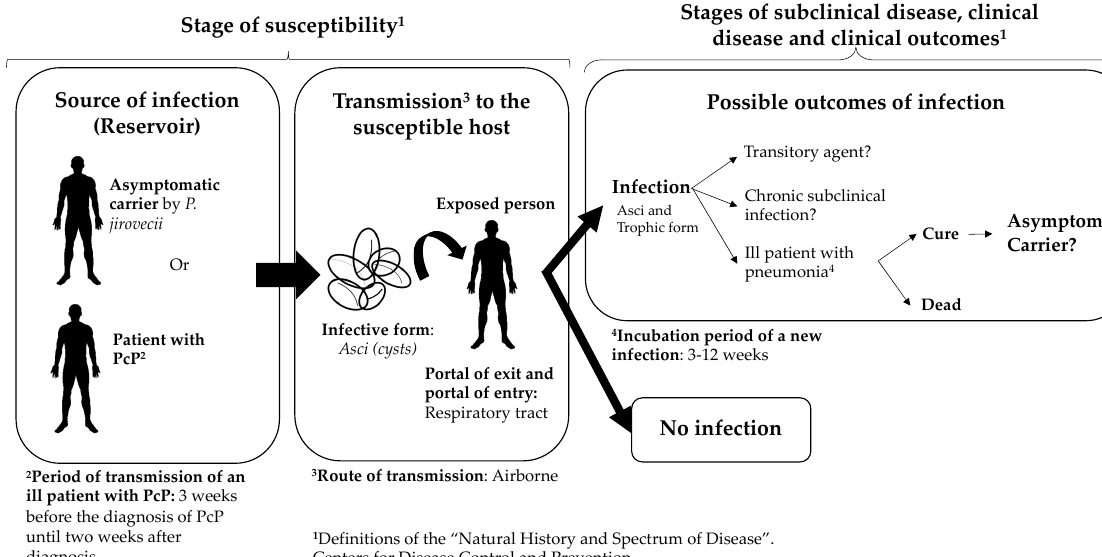
Figure 2. Hypothetical representation of the natural history of Pneumocystis jirovecii . Some of the references that support the definitions used in this figure are: route of transmission [38–41,57,58], infective form [45], incubation period and period of transmission of an ill patient [55]. The question marks in some parts of the figure mean that there are several aspects that are not clear and need further research. We used the definitions of the “natural history and spectrum of disease”, as well as the “chain of infection” in “epidemiology of infectious diseases” from the Centers for Disease Control and Preven ‐ tion. Based on those definitions, and the literature reviewed, we summarized that the reservoir of P. jirovecii is humans and that the transmission is from humans to humans. The source of infection can be asymptomatic carriers or a person with P. jirovecii pneumonia. It has been described that there are carriers of P. jirovecii , both asymptomatic carriers and people with underlying conditions that are colonized by P. jirovecii . However, it is unclear for how long these carriers can be colonized and whether there is a transitory state (it is unclear if the person can be colonized by days, weeks, months, or even years). The portal of entry and exit is the respiratory tract, and the most plausible route of transmission in P. jirovecii is airborne.